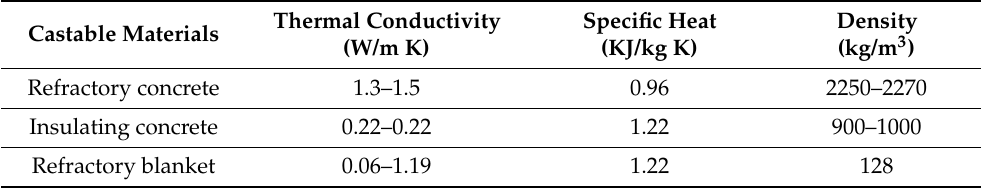
Table 1. Properties of castable materials considered in the numerical